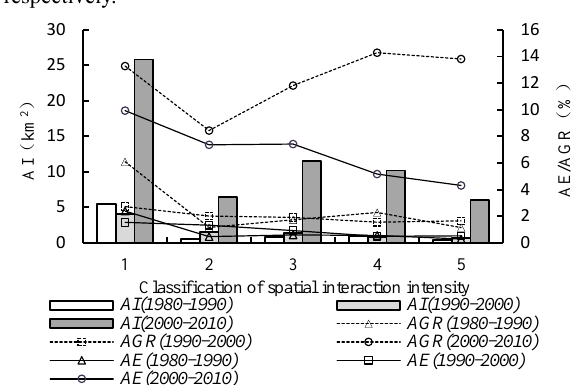
Figure 4. The relationship between spatial interaction intensity and urban expansion